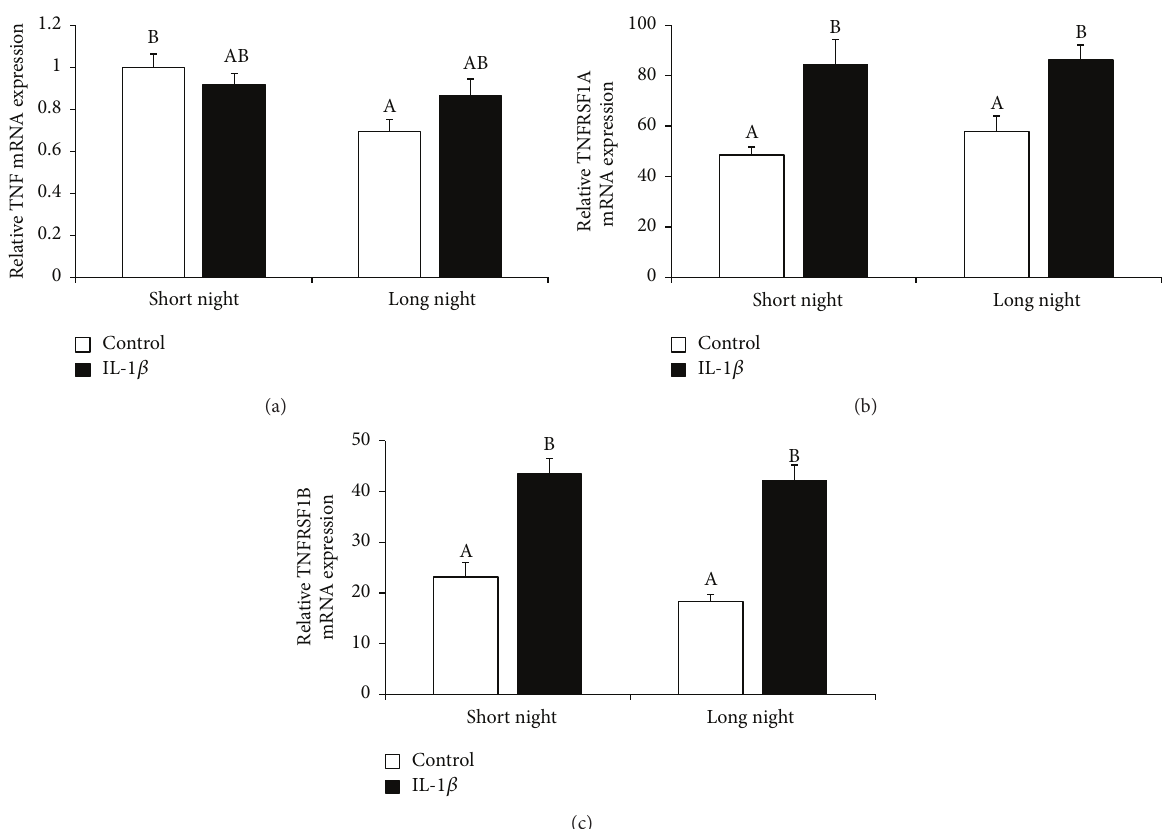
Figure 8: The effects of icv. injection of interleukin- (IL-) 1 𝛽 (50 𝜇 g/animal) or Ringer’s solution (50 𝜇 L) on the relative gene expression (mean ± SEM; 𝑛 = 6 animals per group) of tumor necrosis factor 𝛼 (TNF 𝛼 , (a)), TNF type 1 receptor (TNFRSF1A, (b)), and TNF type 2 receptor (TNFRSF1B, (c)) in ewes during the short night (SN, May/June) and long night (LN, November/December) photoperiods. All data presented in the figure were normalised to the average relative level of TNF gene expression in the control ewes from the SN photoperiod, which was set to 1.0. Different capital letters indicate significant ( 𝑃 < 0.05 ) differences according to a two-way ANOVA followed by Tukey’s post hoc